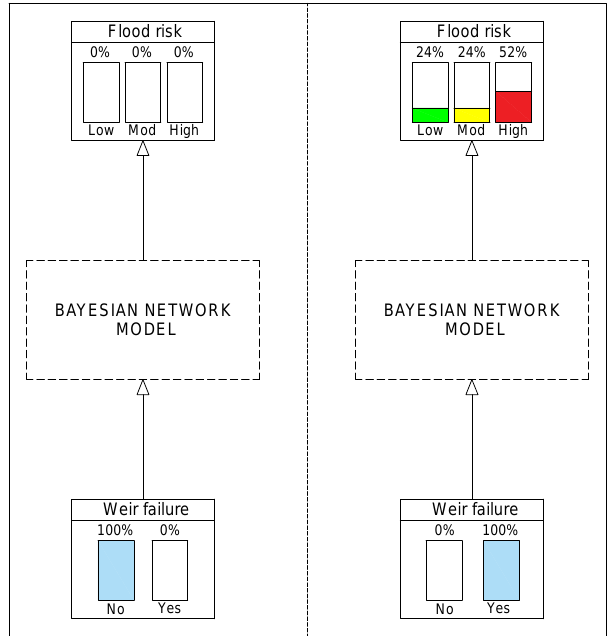
Figure 14. Estimated flood risk with no weir failure ( left ) and due to the weir failure ( right ).